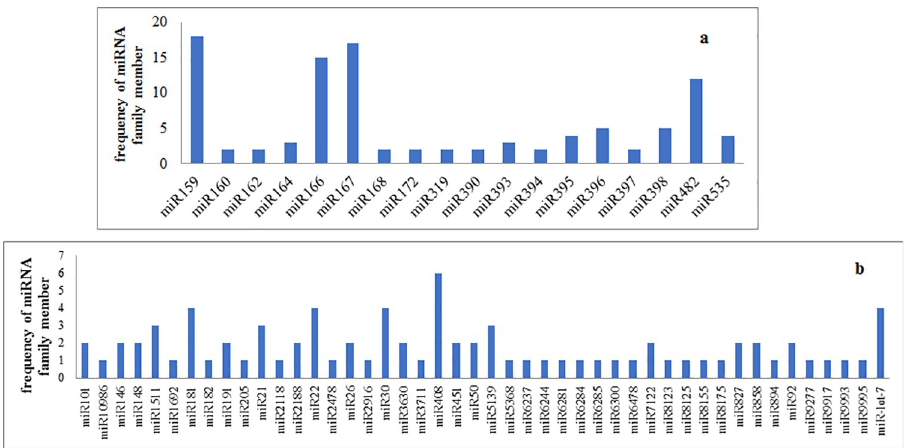
Fig 1. The distribution of known miRNA families in almond. a: Highly conserved; b: Conserved in some